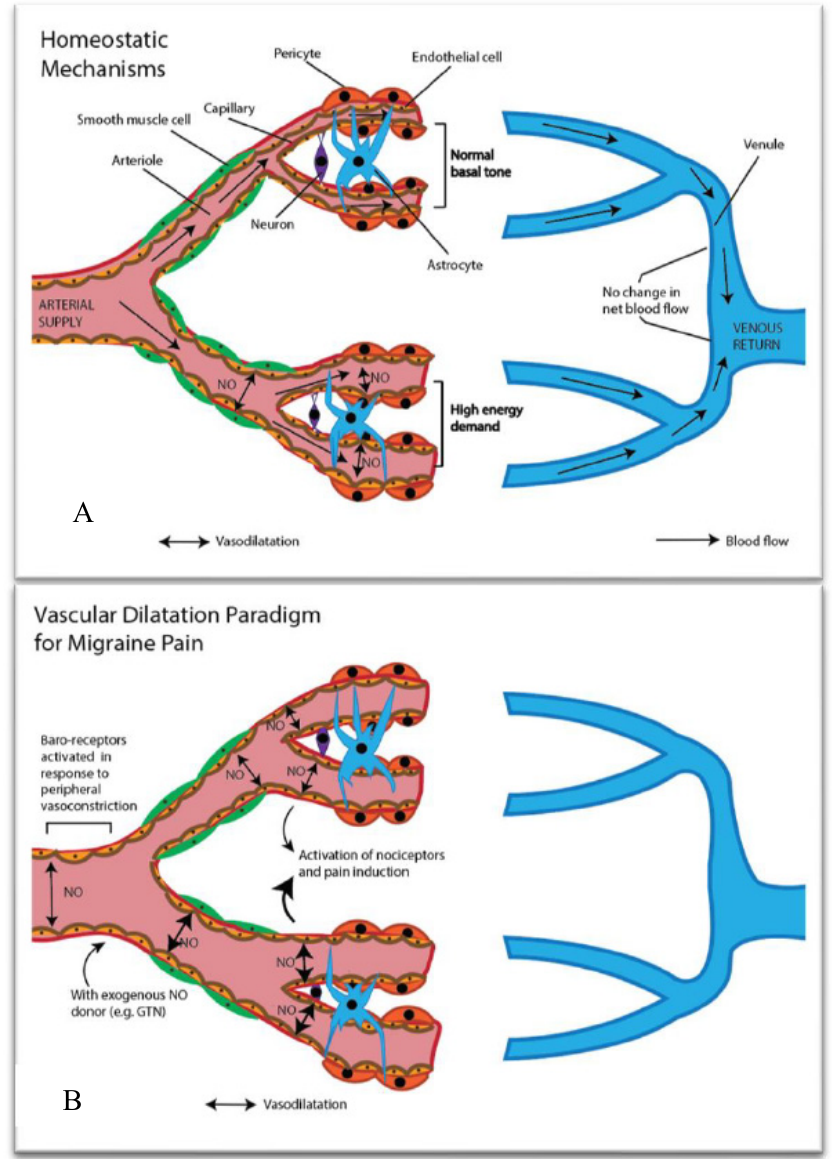
Figure 2. Homeostatic microvascular tone modulation and the prevailing microvascular dogma in the migraine literature. ( A ) Focal brain parenchymal changes in energy demand triggers microvascular vasodilatation, lowering resistance and increasing capillary blood flow (provision of energy substrate). Capillary dilatation is mediated through intrinsic pathway(s), including direct astrocytic modulation of pericytes, and astrocytic and neuronal innervation of endothelial cells to stimulate endothelial nitric-oxide synthase (eNOS), resulting in upregulation of synthesis of the potent vasodilator NO. Parenchymal changes in microvascular flow may be several-fold in response to regional energy demand; however, net cerebral blood flow remains essentially unchanged. “Regional” demand may result in upstream vasodilatation of the arterioles, in order to adequately supply larger regions of tissue during periods of heightened energy demand, and to maintain hydrostatic arterial pressure. ( B ) Exaggerated sympathetic tone results in peripheral vasoconstriction—for example, in the head and neck muscles. Vasomotor sympathetic-induced peripheral vasoconstriction activates baroreceptors in central large arteries, by activating eNOS and stimulating production of NO. Exaggerated NO stimulates nociceptors and induces cortical spreading depression via K + release, causing migraine aura. NOS are purported to alleviate headache pain by inhibiting attenuation of vasodilatation. GTN = glyceryl trinitrate.